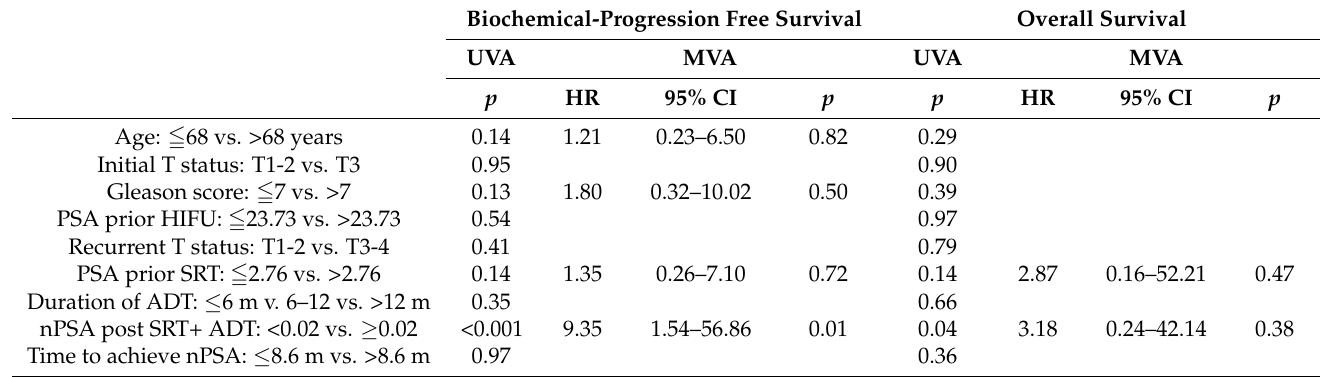
Table 2. Cox regression model to predict variables associated with biochemical progression free survival and overall